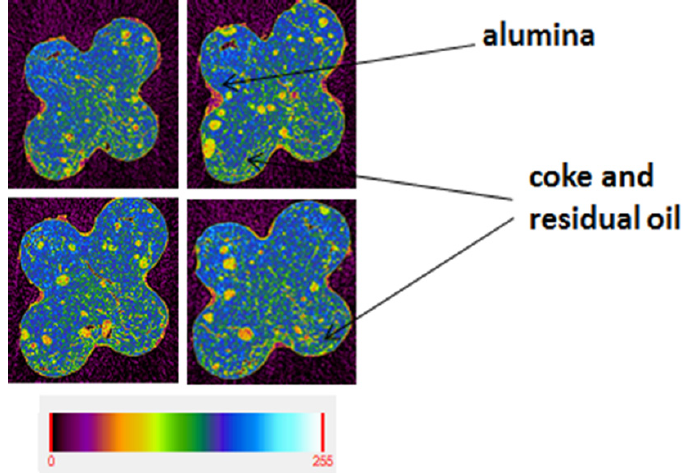
Figure 5. X-ray nano-CT 2D slice images of the spent catalyst after catalytic upgrading at a temperature of 425 °C, pressure 15 barg, N 2 gas-to-oil flow ratio 400 mL/mL, catalyst-to-steel-balls ratio 66% (v/v), tetralin-to-oil ratio 0.045 (g/g) and 4 h TOS taken at different position.